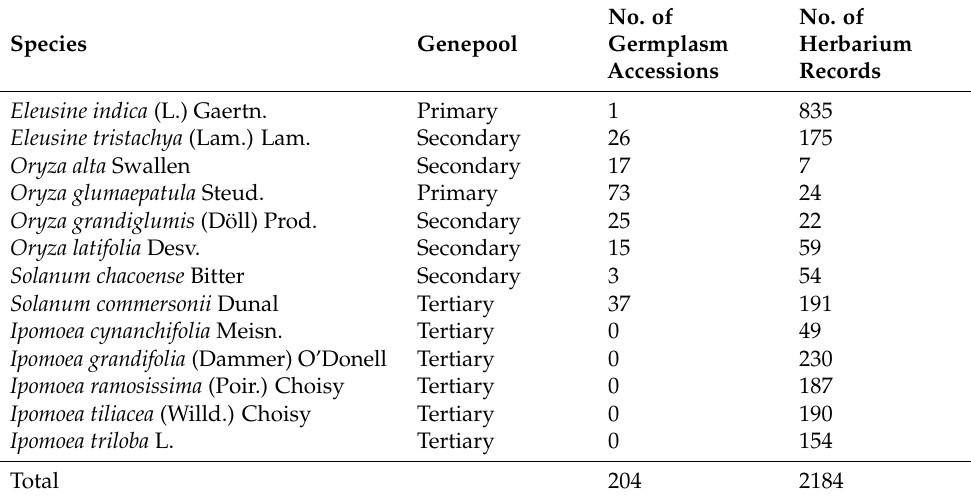
Table 1. List of species evaluated, gene pool, number of georeferenced records for herbarium occurrence and germplasm accessions conserved ex